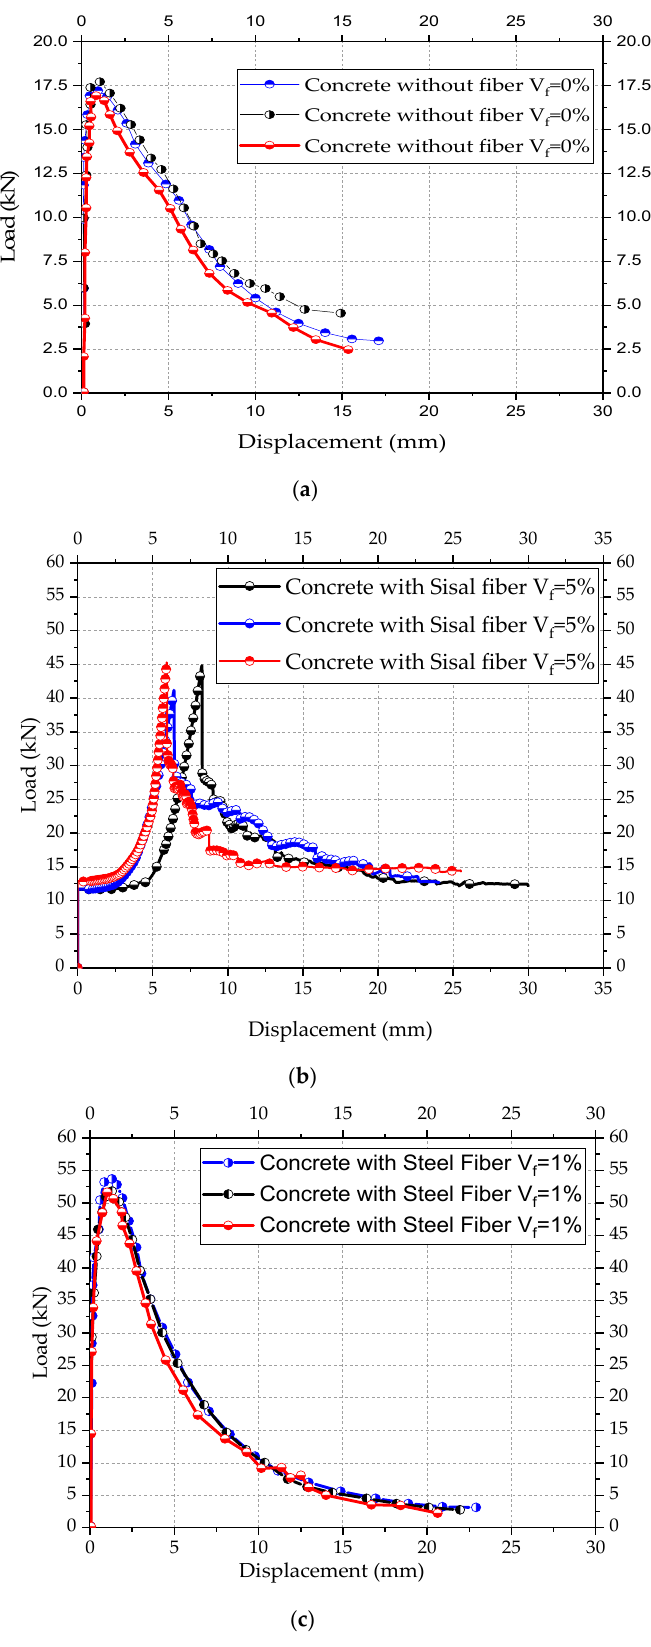
Figure 14. Results of experimental tests. ( a ) Four-point bending beam test, ( b ) compression test, ( c ) tensile indirect test.